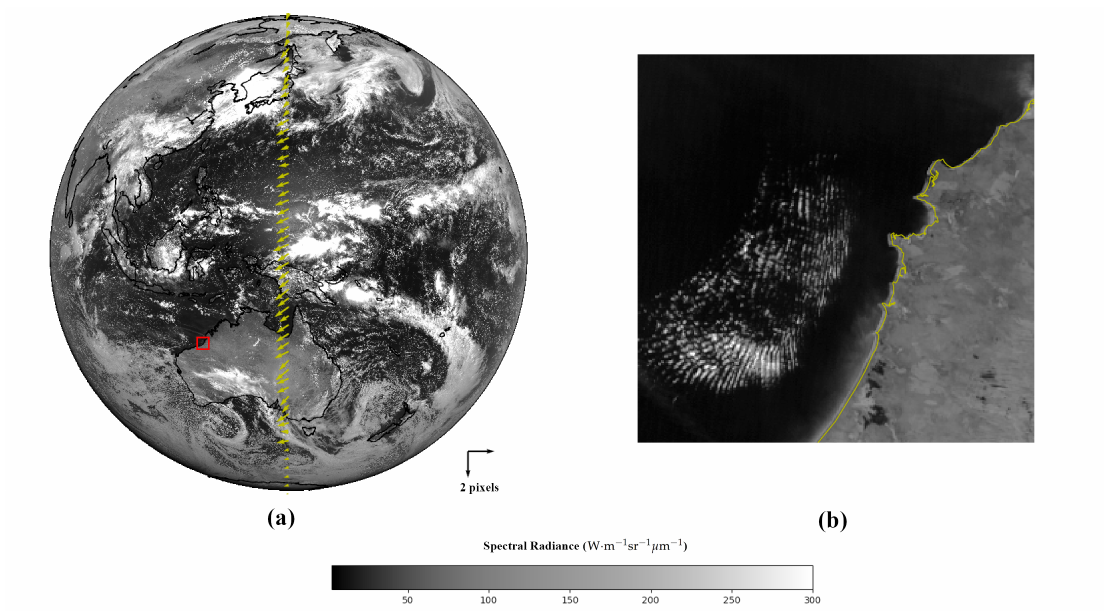
Figure 7. Same as Figure 5, but for Himawari-8 AHI on 2018/05/02, 02:00 UTC. The area marked by the red rectangle in Panel ( a ) and enlarged in Panel ( b ) is near the La Grange Bay of Western Australia. The 0.64 µ m channel is Band 3 on AHI.